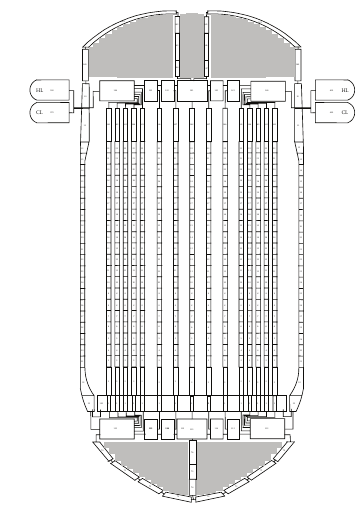
Figure 3: CNA-I PHWR NPP core